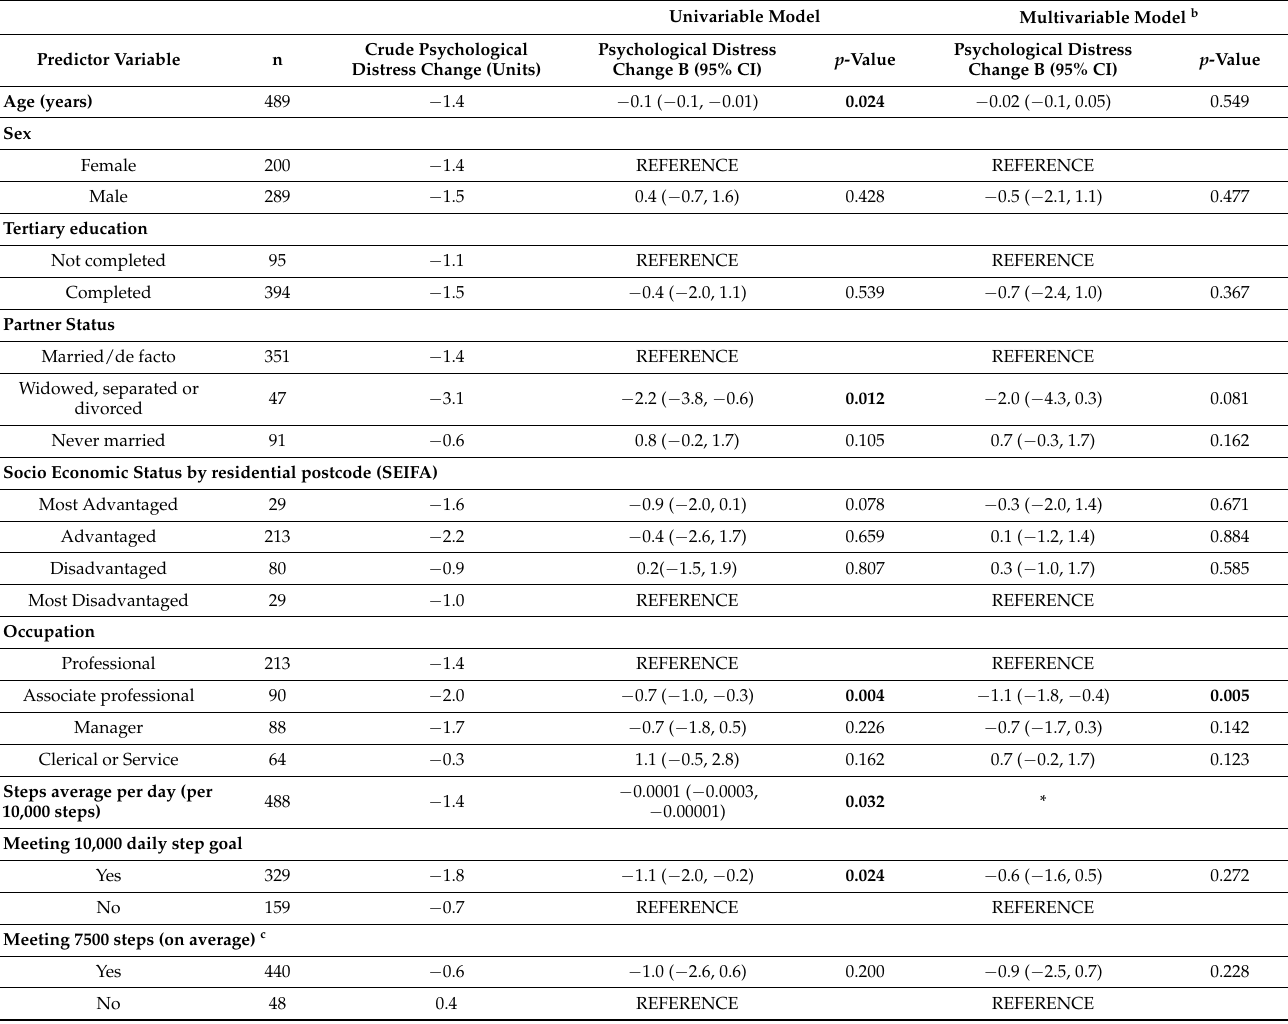
Table 2. Predictors of change in psychological distress (K10 score) at 4-months, n = 489 a